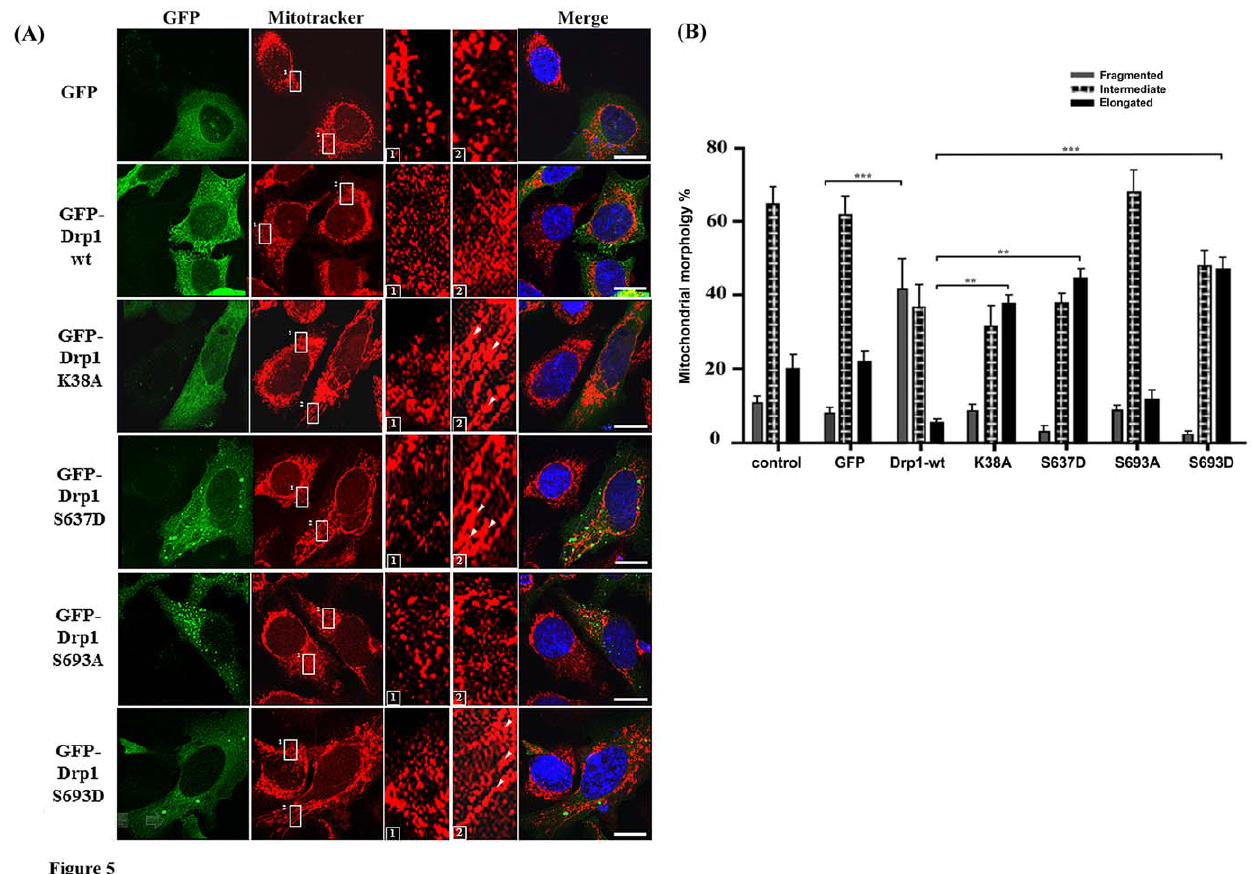
Figure 5. Mitochondrial dynamics of HeLa cells with Drp1 wt and mutants. (A) HeLa cells were transfected with GFP-tagged Drp1 wt or other mutants for 24 hours. Mitochondrial morphology was observed by confocal fluorescent microscope with Mitotracker dye. Cell nuclei were counter-stained by DAPI. Insets are magnifications of the Mitotracker signal at the indicated areas. Inset 1 represents the non-transfected cells, and inset 2 indicates the transfected cells. Indications (white arrows) represent typical elongated mitochondria morphology. (B) Statistical result of mitochondrial morphology. After 24 hours, over 100 transfected cells were categorized into 3 groups depending on mitochondrial morphology. *p , 0.05, **p , 0.01, ***p ,